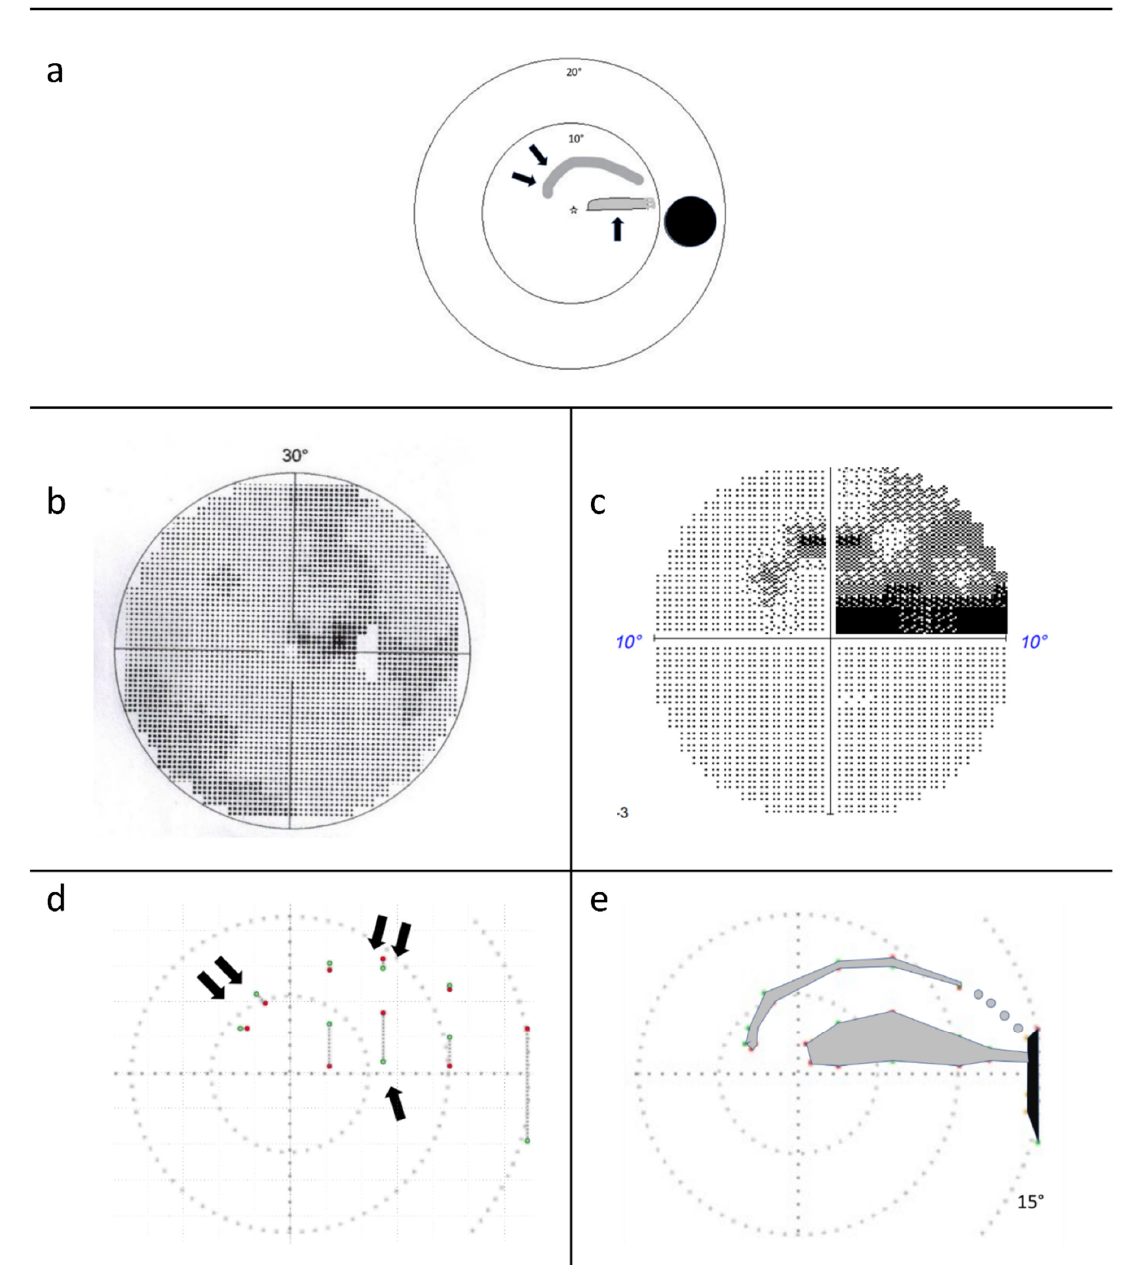
Figure 1. F.H. Visual field findings. ( a ) Sketch of the grey, drawn scotoma in the visual field of the right eye subjectively perceived by F.H. (first scotoma—one arrow, second scotoma—two arrows). ( b ) 30° field of view examined with Octopus 301. The scotoma is dark grey in the temporal upper field of view, the blind spot is shown in white. ( c ) 10° central visual field examined with the Humphrey Field Analyzer (HFA3). The absolute scotoma is black in the temporal superior visual field, and the relative scotoma is dark grey in the temporal and nasal superior visual fields. ( d ) Red and green dots, connected by a grey line, represent the beginning and end of the scotoma in the paramacular visual field after the screening procedure. One arrow marks the first scotoma, two arrows marks the second. ( e ) The 15° central visual field findings of scotoma delineation campimetry. After finding the two scotomas in the screening procedure, the exact scotoma borders were determined. The four grey spots between the arcuate scotoma and blind spot (black) represent the presumed scotoma course. In this area, the test point is thicker than the narrow scotoma and